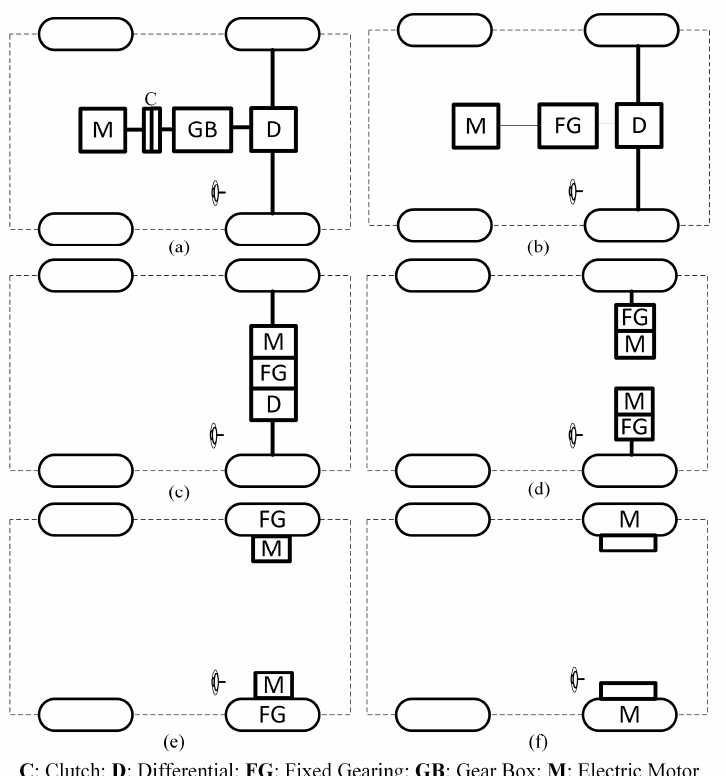
Figure 11. Different front wheel drive EV configurations. ( a ) Front-wheel drive vehicle with the ICE replaced by an electric motor; ( b ) Vehicle configuration with the clutch omitted; ( c ) Configuration with motor, gear and differential combined as a single unit to drive the front wheels; ( d ) Configuration with individual motors with fixed fearing for the front wheels to obtain differential action; ( e ) Modified configuration of Figure 11d with the fixed gearing arrangement placed within the wheels; ( f ) Configuration with the mechanical gear system removed by mounting a low-speed motor on the wheel rim. Adapted from [4].